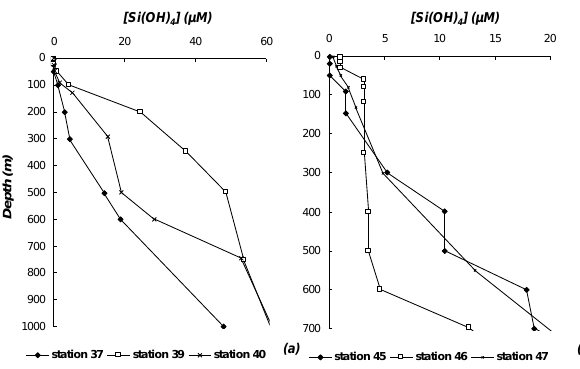
Fig. 6. Vertical distributions of silicate concentrations (Si(OH) − µM), (a) in the core of the cyclonic eddy-S (station 39) and the surrounding stations (stations 37 and 40); and (b) in the core of the anticyclonic eddy-M (station 46) and the surrounding stations (stations 45 and